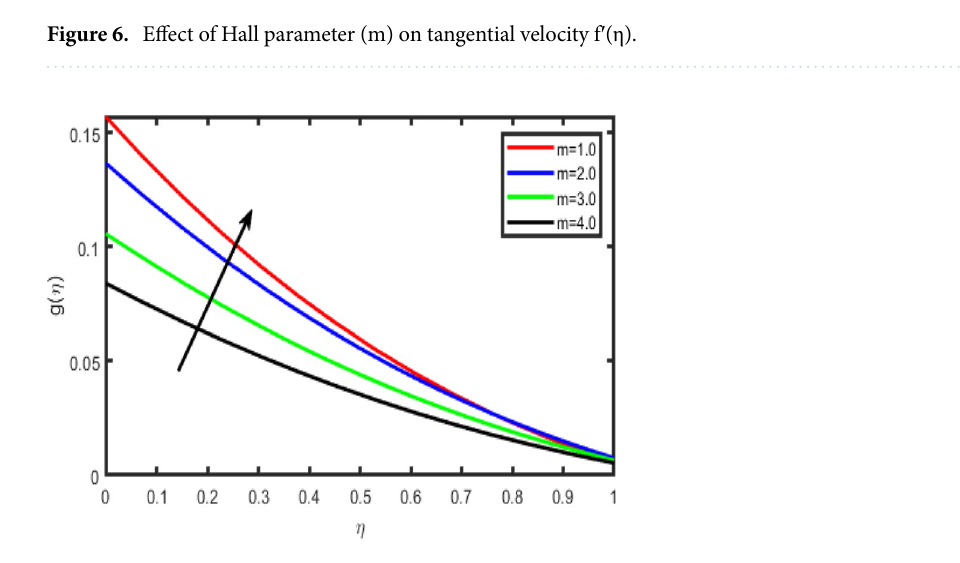
Figure 7. Effect of Hall parameter (m) on transverse velocity